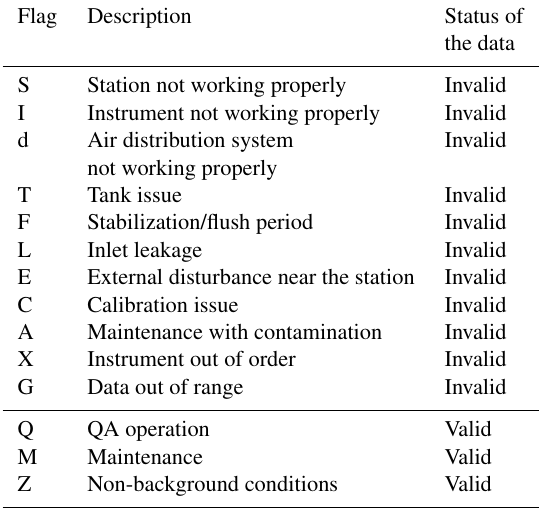
Table 2. List of descriptive flags. The descriptive flag is instrument independent and is picked from a predefined list. The flag is case sensitive. Multiple flags (i.e., letters) can be set simultaneously on a single value. There is a list to be used for invalid data and one to be used for valid